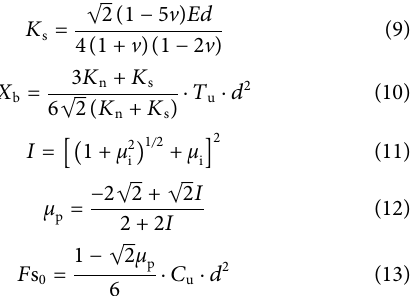
FIGURE 8 Tanjiahe landslide. (A) Numerical model. (B) Layout of landslide monitoring